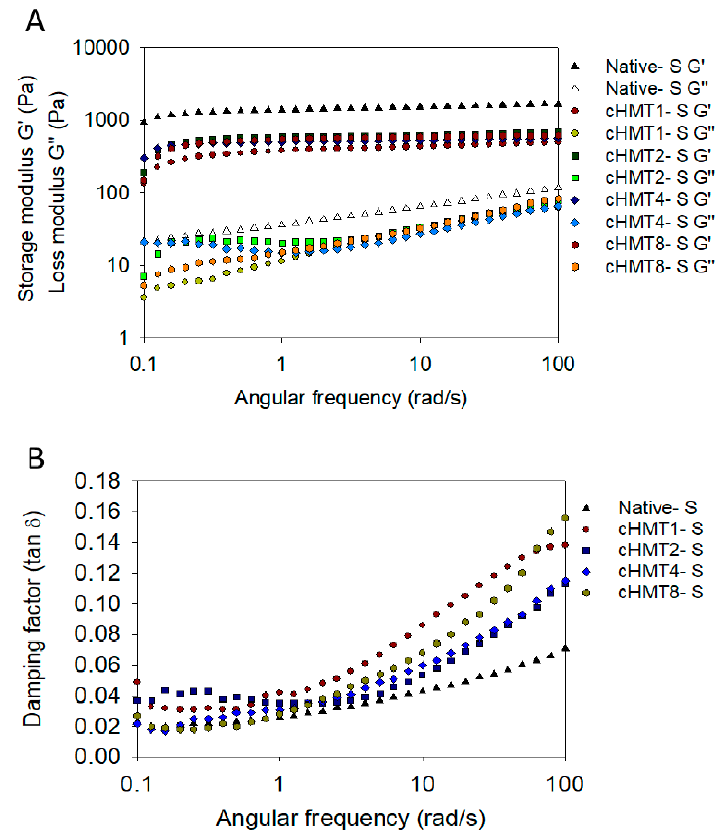
Figure 3. Dynamic rheological behavior of native and cHMT water caltrop starch. ( A ) Angular frequency dependence of G ′ and G ″ at 25 °C for starches; ( B ) angular frequency dependence of tan 𝛿 at 25 °C for starches.